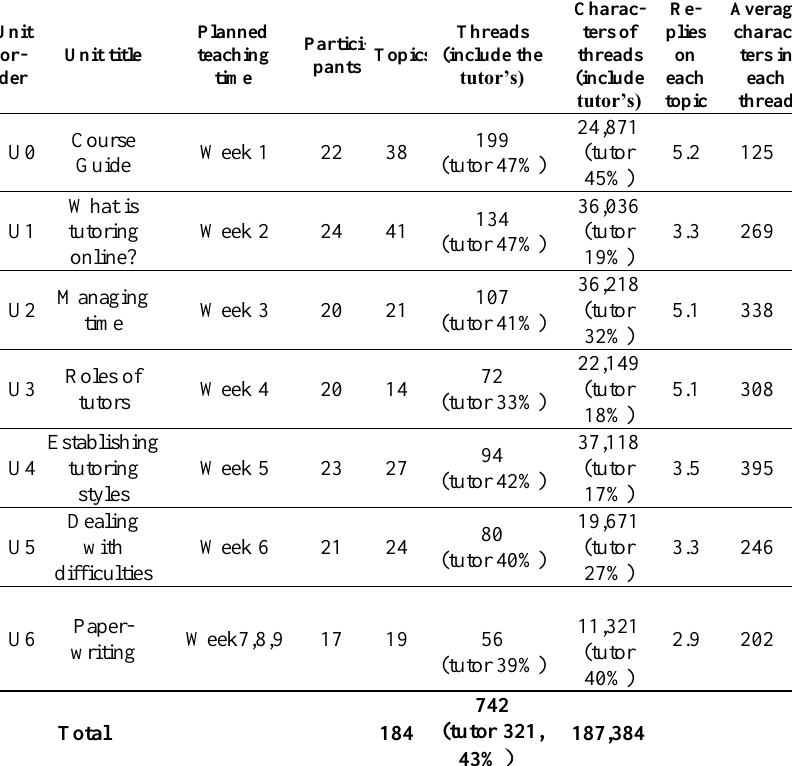
General situation in the